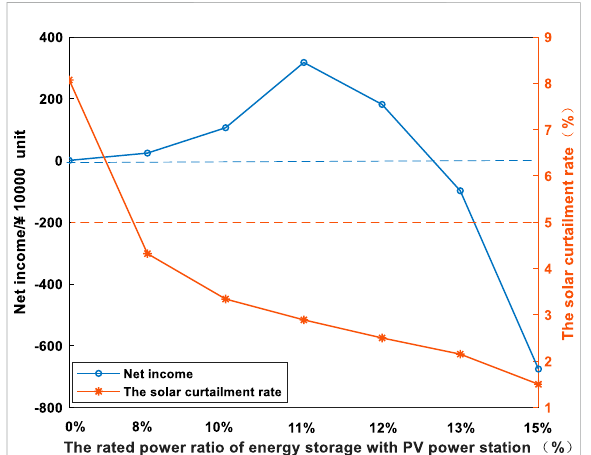
FIGURE 11 Annualunquali fi edforecastingpowerpointsandpenaltywith different rated power ratios.